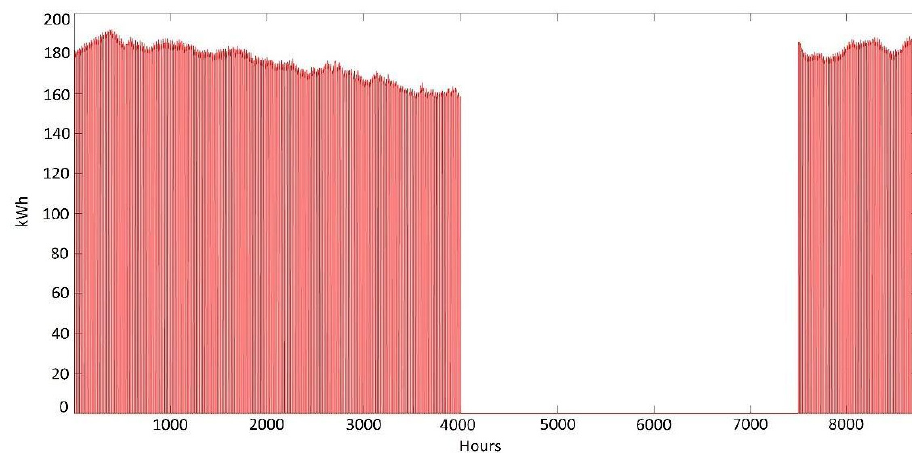
Figure 8. Fan coils hourly thermal energy trend.